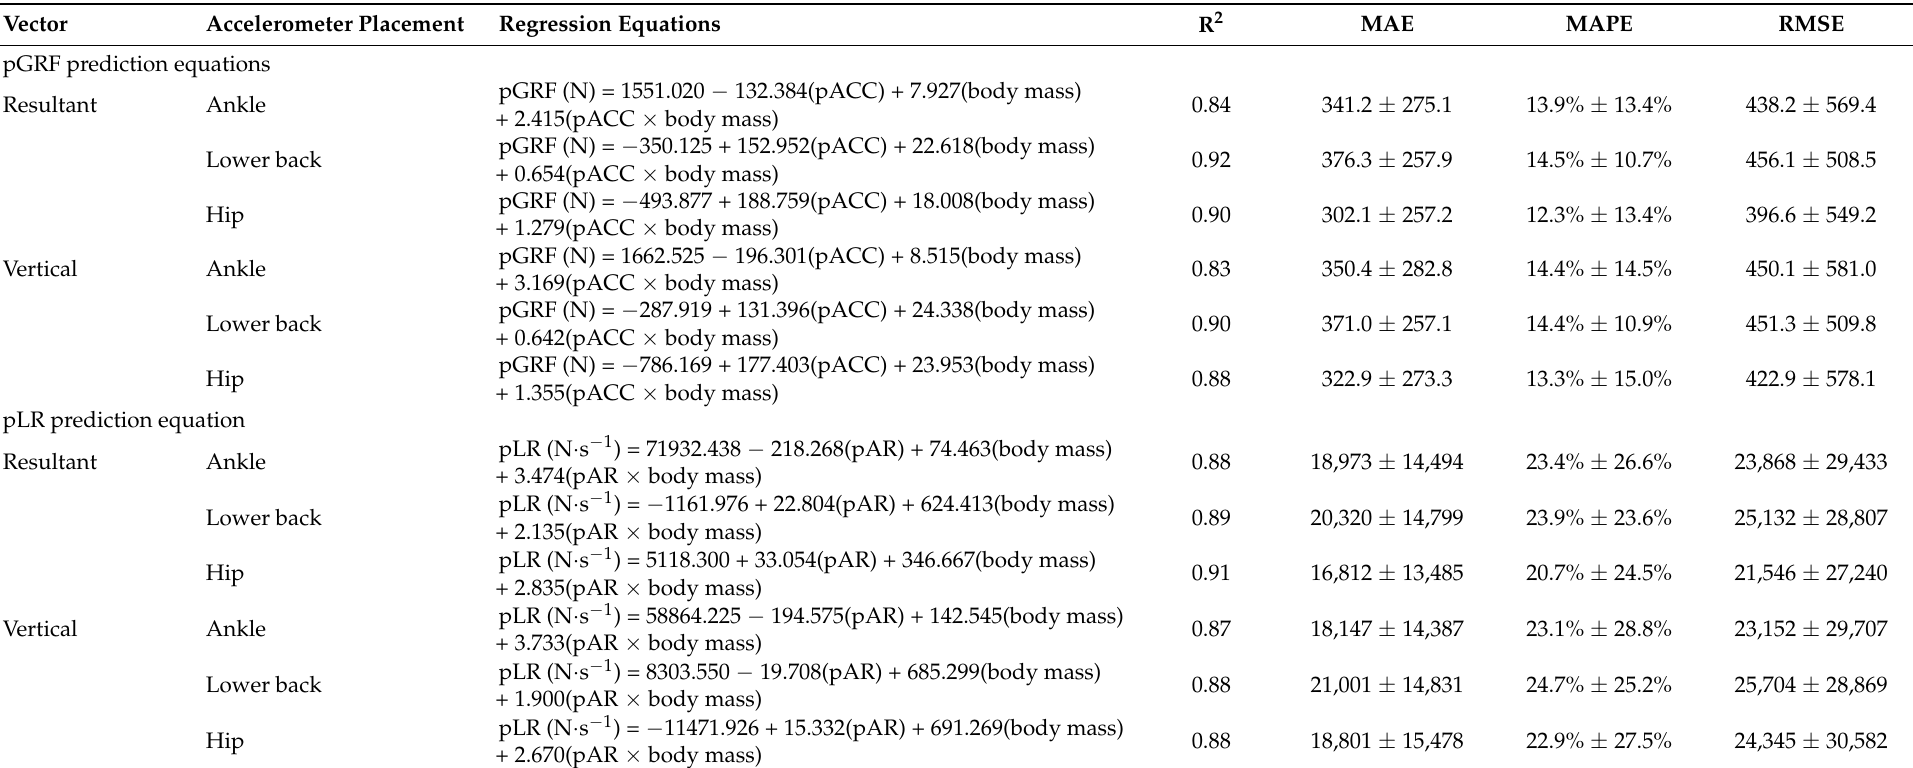
Table 1. Regression equations, R 2 , and accuracy indices for prediction of pGRF and pLR based on accelerometer-derived